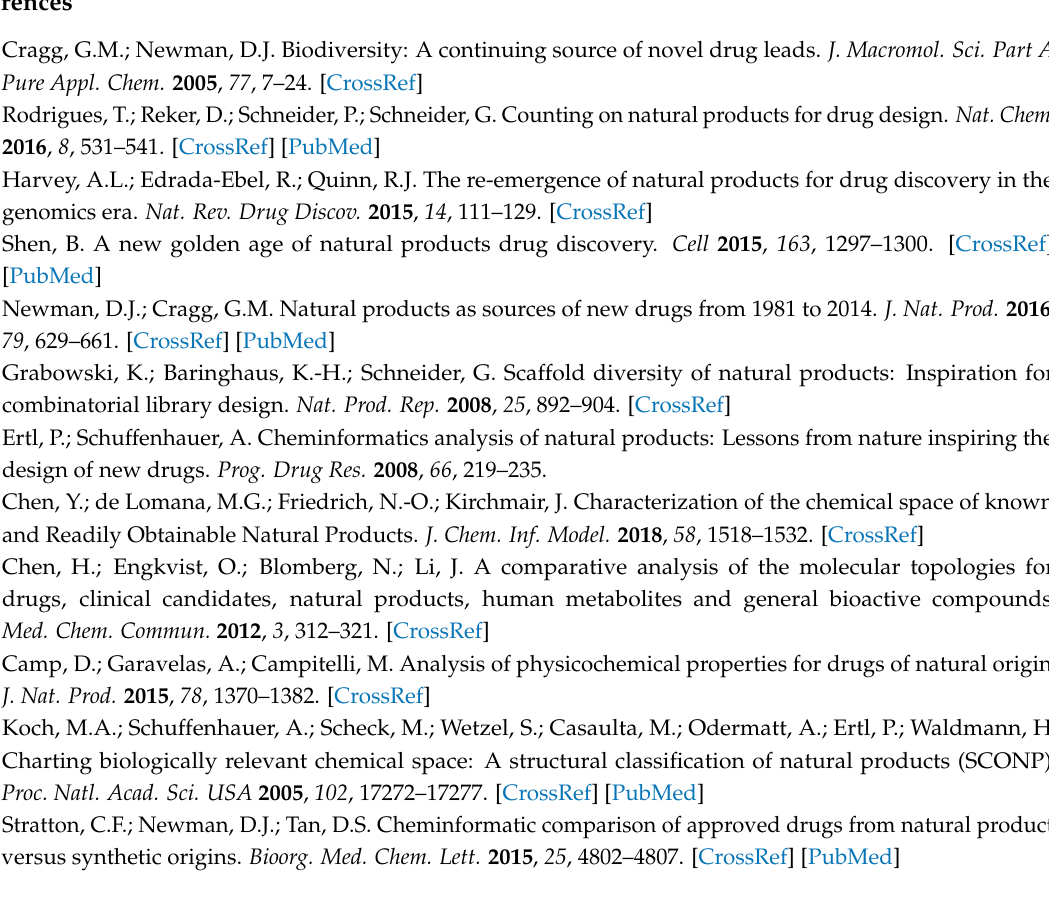
Figure S1: Distribution of calculated NP-likeness scores for the DNP (after removal of any compounds present in the training